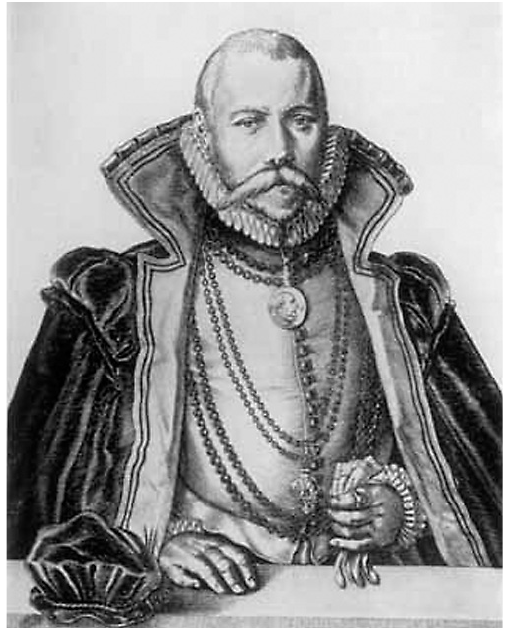
Figure 1. Tycho Brahe (1546–1601).